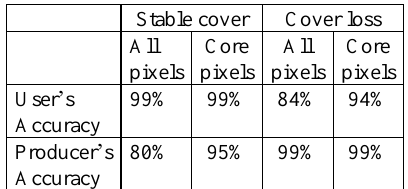
Table 5 . Accuracies of best model with three post-change images used post-processing input data.